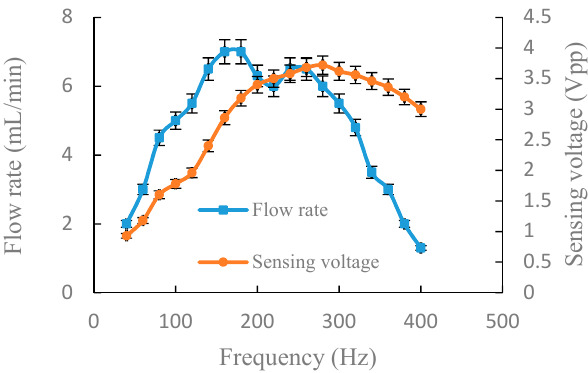
Figure 5. Output flow rate and sensing voltage under a fixed voltage of 150 Vpp in serial connection.